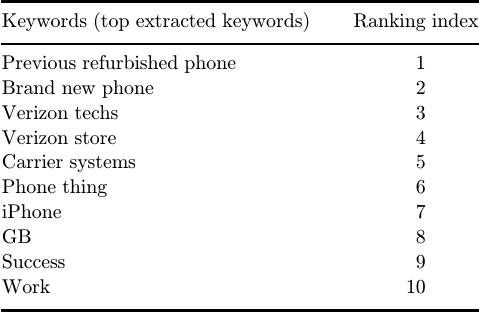
Table 2. Set of keywords extracted using AlchemAPI. Keywords (top extracted keywords)